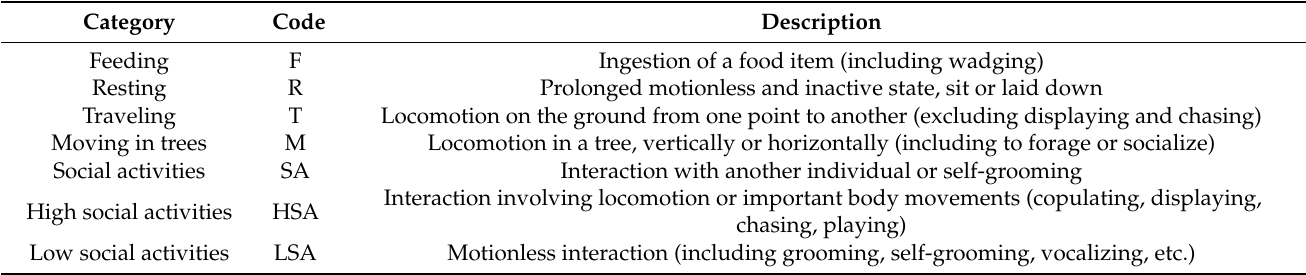
Table 1. Ethogram of the behavior categories used in the evaluation of chimpanzees’ energy balance in Kibale National Park,